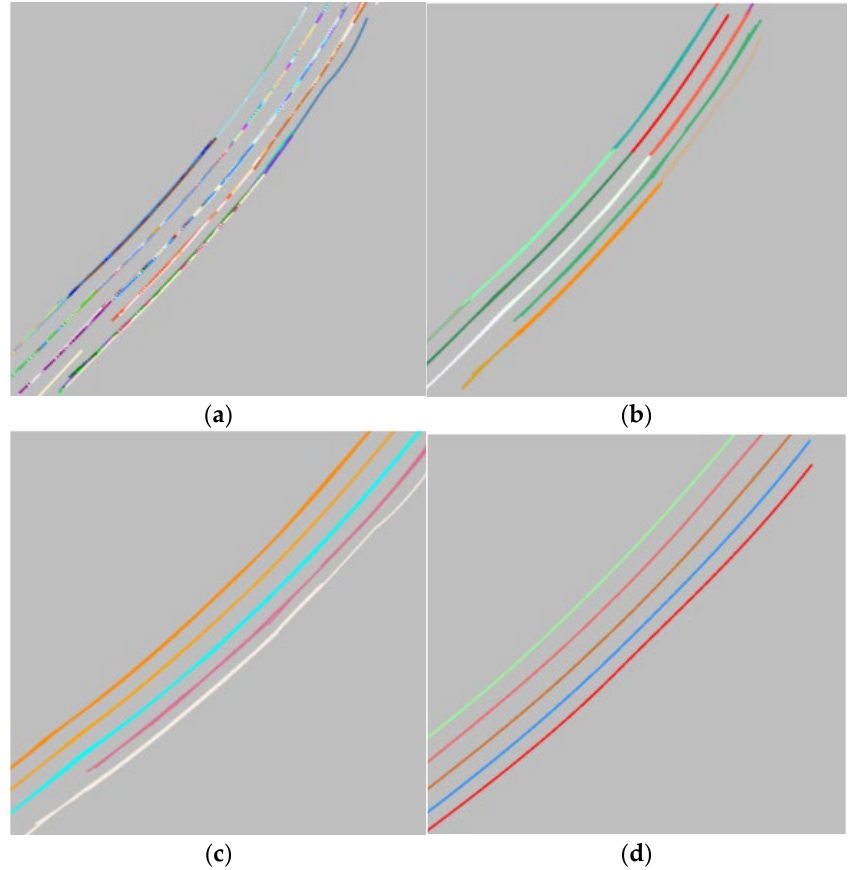
Figure 6. Schematic diagram of lane aggregation algorithm. ( a ) LSM lane lines, where different colors represent different lane lines; ( b ) effect picture after the first stage of clustering, where different colors represent different clusters; ( c ) effect picture after clustering in the second stage, where the same color represents one instance; and ( d ) results after vectorization.